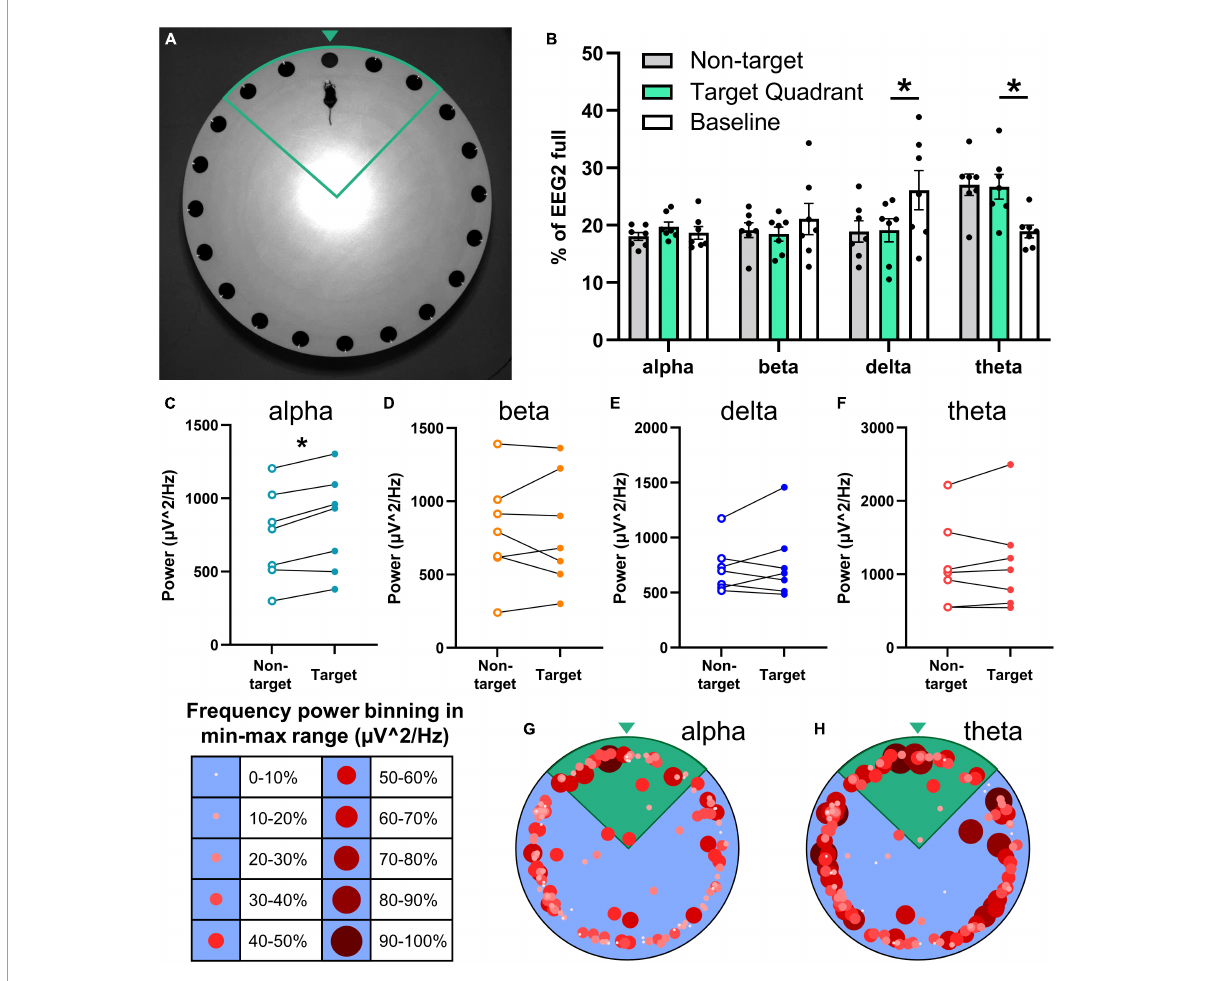
FIGURE5 Relationship of the neuronal frequency with Barnes maze performance. EEG/EMG mice ( n = 7) were tested in the Barnes maze as a proof-of-concept of combining recordings with cognitive testing. Mice learned the task successfully (refer to Supplementary Figures 5A,B ) across four trial days (two trials per day) and were tested for spatial memory 2 days later in a probe trial in which the previously acquired escape location was blocked. (A) Mice with the potentiostat plugged-in navigate the Barnes maze successfully (refer to Supplementary Figure 3B ), demonstrated here in the target quadrant (green outline) approaching the target zone (green arrowhead). (B) Neuronal power was generated in 2-s intervals, normalized to full EEG signal, and binned by mouse location in the Barnes maze (non-target and target quadrant), as well as at baseline (not performing task). While searching for the escape in the target quadrant, mice exhibit significantly lower delta power and significantly greater theta power than at baseline. Paired power comparisons of non-target vs. target quadrant determined significantly greater alpha power (C) in the target zone, and no differences for beta (D) , delta (E) , theta (F) , and EMG (refer to Supplementary Figure 5C ) during the task. (G,H) Alpha and theta power were binned as a proportion (10% intervals) of the total power range recorded at each 2-s interval and graphed by size, color, and xy location in the Barnes maze. These heatmaps demonstrate higher alpha power in the target quadrant (green), and high theta throughout the maze. Representative heatmaps were generated in the same mice; positional data is the same for both. Data are mean ± SEM (B) or paired before-after comparisons (C–F) . Multiple paired t -tests with multiple comparisons were controlled for with the Holm–Šídák method. * P <